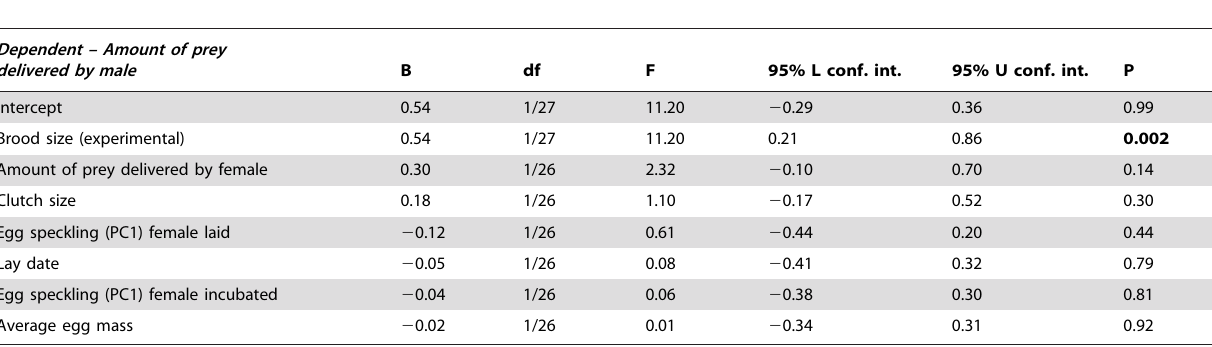
Table 1. General Linear Model showing the amount of prey delivered by males was not related to the speckling on the eggs his partner laid or the eggs that he saw during incubation (N =29